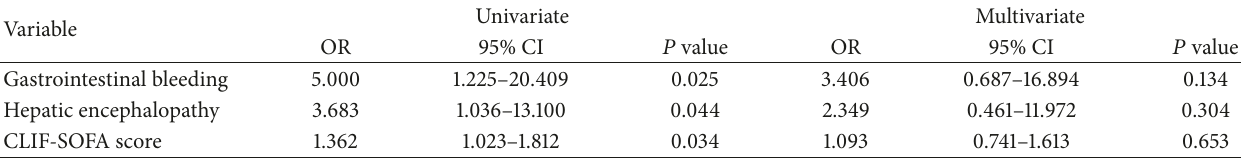
Table 2: Significant univariate and multivariate logistic regression analyses of 28-day transplant-free mortality.